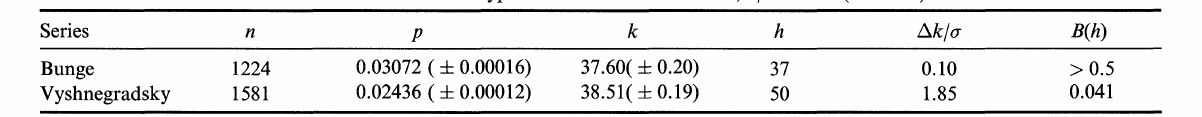
TABLE IV Bernoulli hypothesis tests for ruble data, O#r= -0.5( + 0.005)